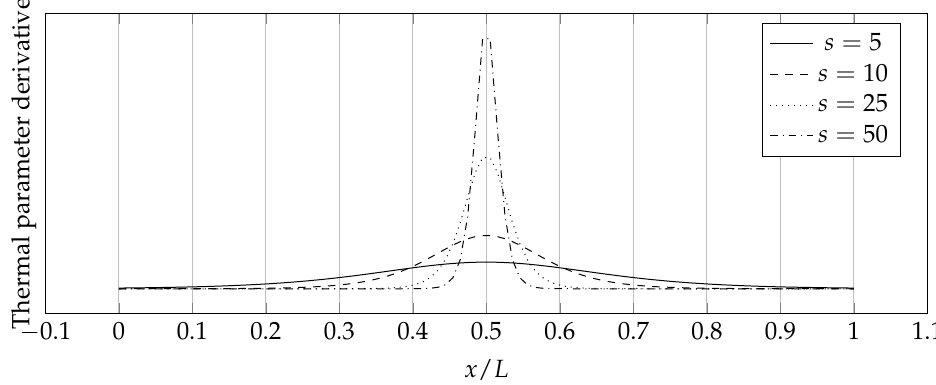
Figure 6. Derivative of the logistic function for various values of s .